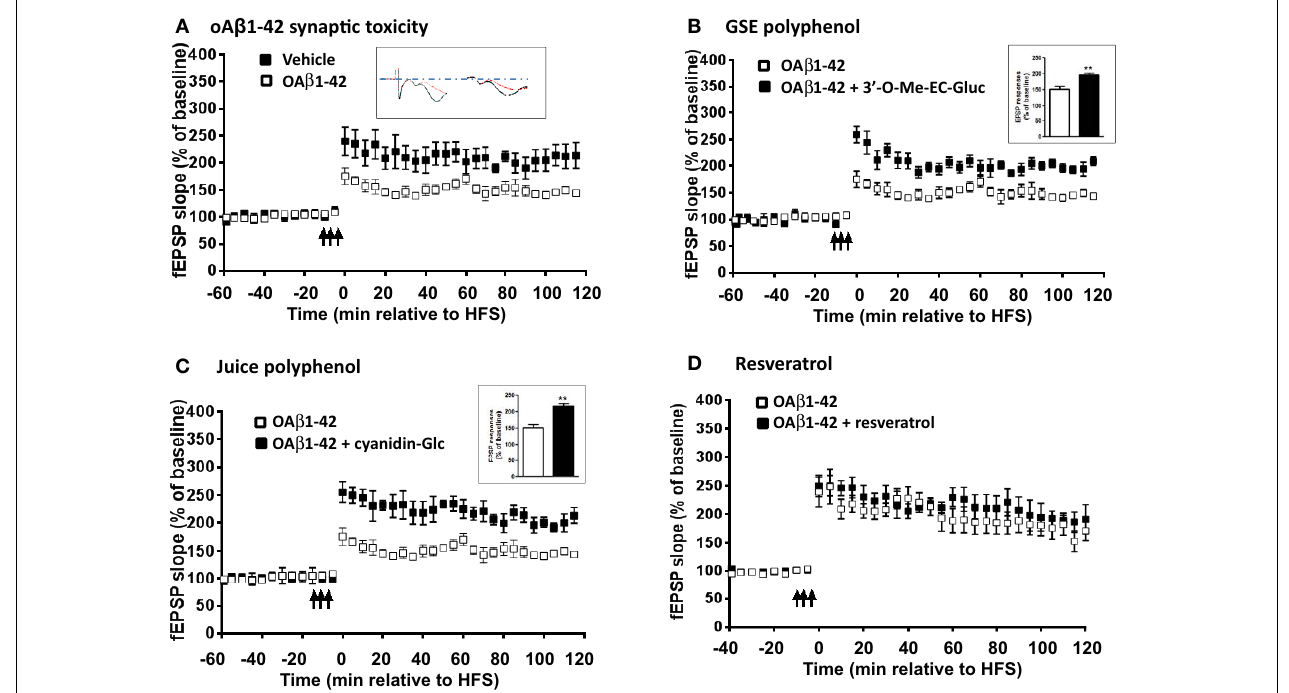
FIGURE 3 | Select brain-penetrating polyphenolic metabolites from GSE and Concord grape juice are bioactive in preventing acute oA β -induced LTP impairment. Ex vivo hippocampal slices from wild type (WT) mice were acclimated in oxygenated artificial cerebrospinal fluid and challenged with (A) 200nM of oA β (B) 200nM oA β co-treated with 3 (cid:4) - O -Me-EC-Gluc (300nM), (C) 200nM oA β co-treated with cyanidin-Glur (300nM) and (D) 200nM oA β co-treated with resveratrol (20 μ M) for 1h before recording. The fEPSPs were